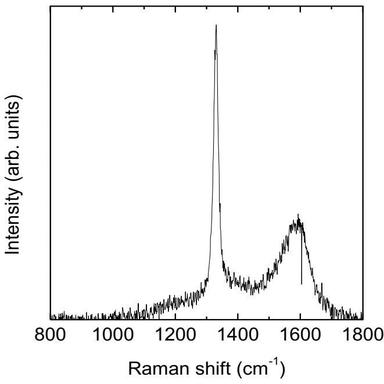
Raman spectrum of the 310 nm-thick diamond heteroepitaxial layer grown on Ir/STO/Si (100). UV laser excitation at 325 nm.